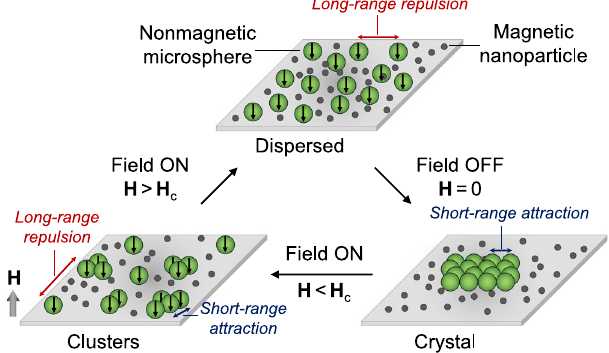
Fig. 1 Schematic of microparticle assembly in magnetic nanoparticle dispersion. A suspension of microparticles immersed in a MNP dispersion undergoes a cycle of assembly and disassembly. When no external magnetic fi eld is applied ( H = 0), the discrete nature of the nanoparticle dispersion induces a short-range depletion attraction between the microsphere which assemble into crystal structures. When the external magnetic fi eld is applied with a magnitude lower than a certain critical value ( H < H c ), the microparticles become polarized due to the continuous nature of the MNP dispersion: a long-range magnetic repulsion ensues in competition with the short-range depletion attraction causing the assembly of small microparticle clusters. The black arrow within a microparticle represents the dipole moment vector. At relatively high fi eld strength ( H > H c ), the magnetic repulsion between microparticles overcomes the depletion attraction and acts to maintain a disordered